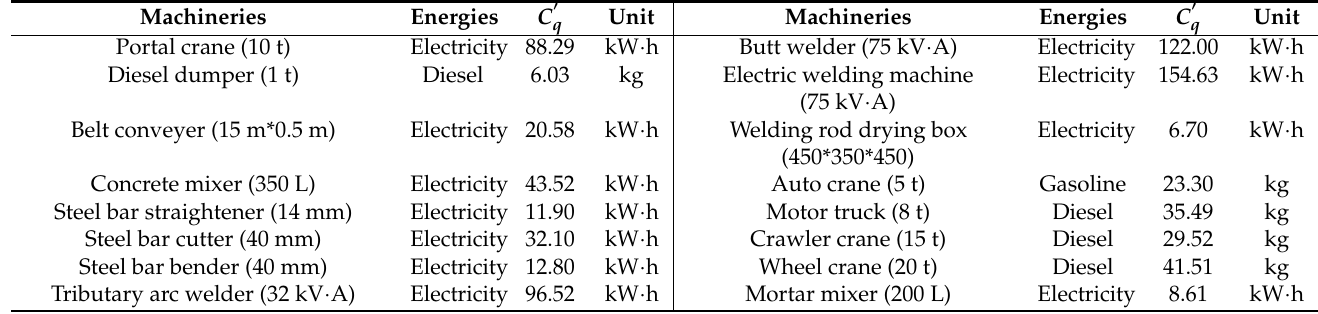
Table 10. The Energy Consumption per Machine-team of Above